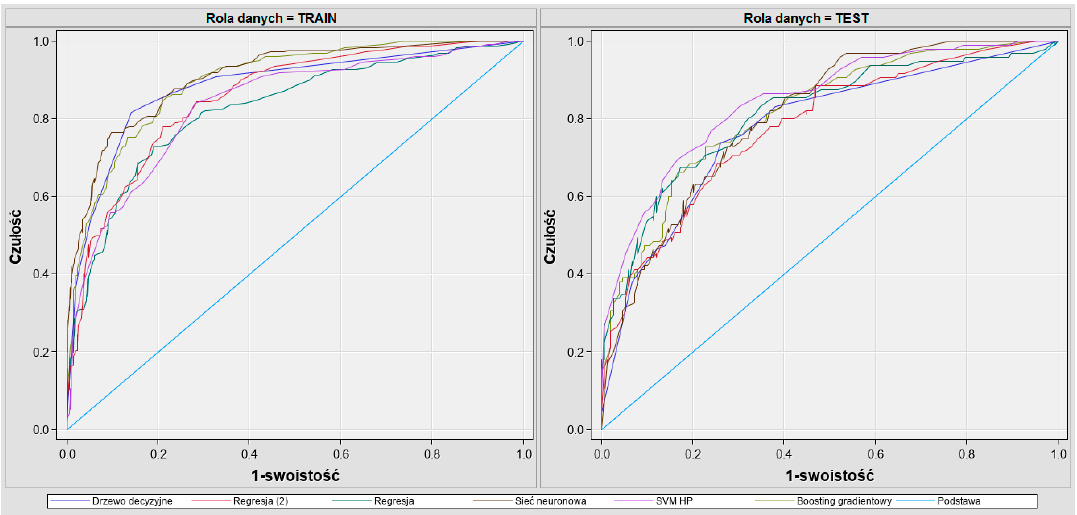
Figure 6. ROC curve for all models, train and test sample.